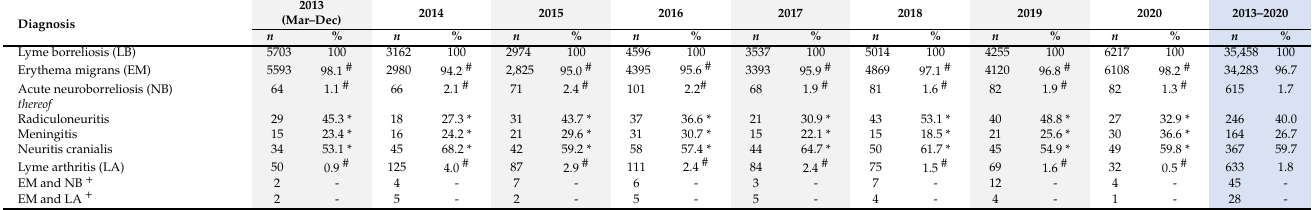
Table 1. Reported cases and clinical manifestations of LB in Bavaria, Germany, 2013–2020 ( n = 35,458).